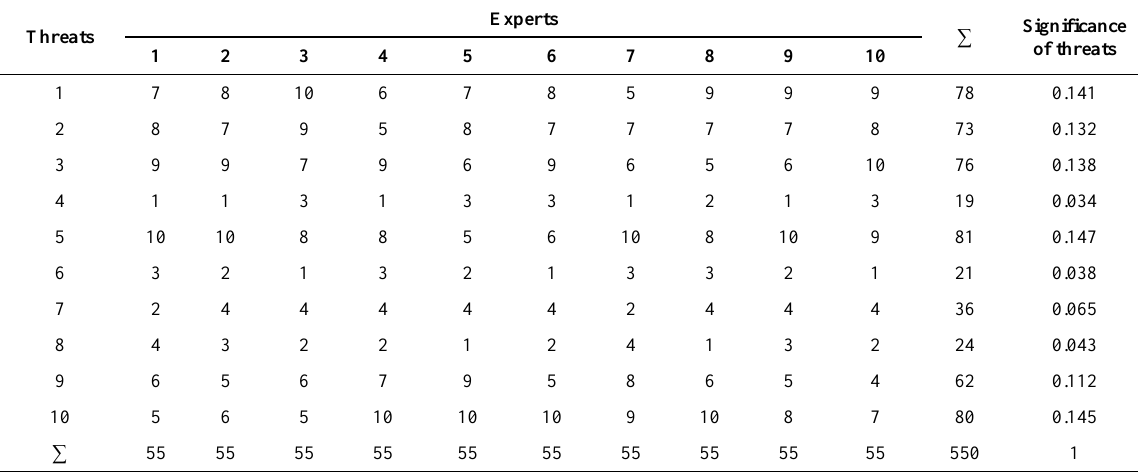
Table 3. Assessment of